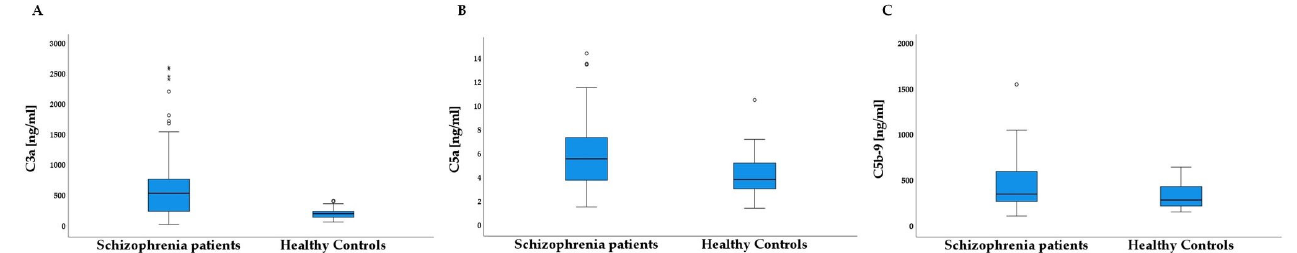
Figure 1. Comparisons of the mean number of complement components between schizophrenia patients and healthy controls (( A ) = for C3a; ( B ) = for C5a, and ( C ) = for C5b-9). In all box plots, the bottom end of the box designates the first quartile, a line within the box indicates the median and the top end of the box shows the third quartile. Whiskers indicate values 1.5 times the interquartile range below the first quartile and above the third quartile. Crosses represent average values. Circles designate individual observations.